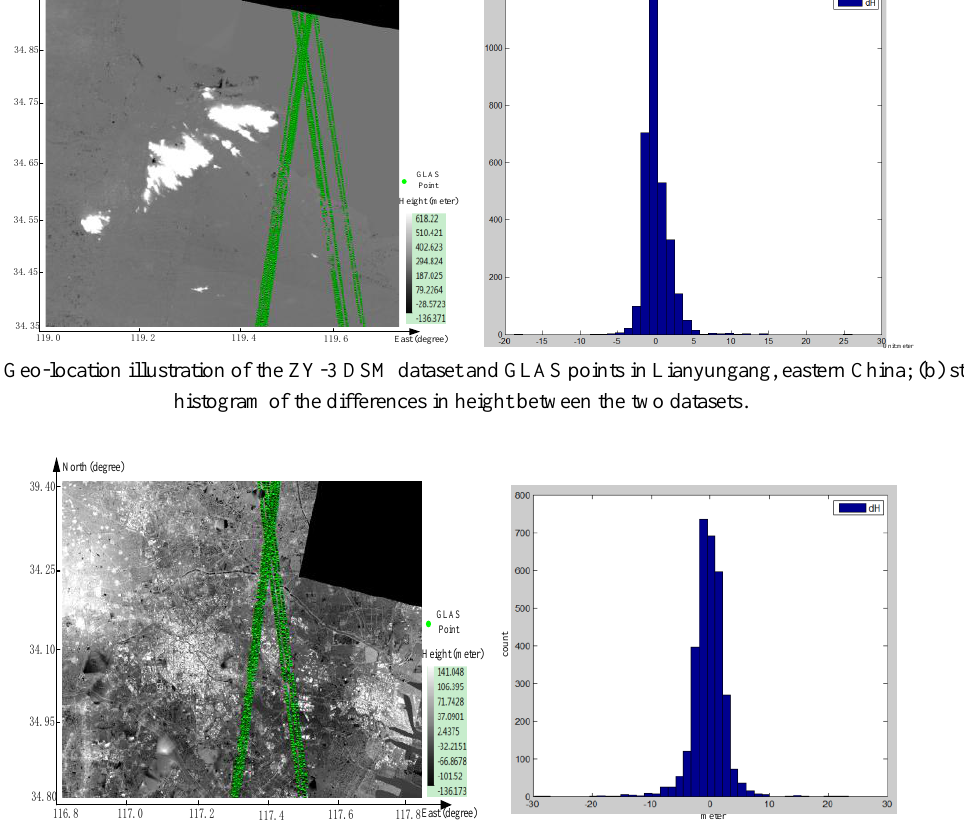
Figure 3. (a) Geo-location illustration of the ZY-3 DSM dataset and GLAS points in Tianjin, northern China; (b) statistical histogram of the differences in height between the two